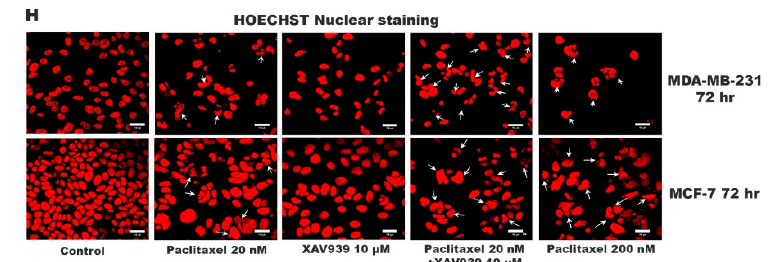
Figure 1. Combination treatment with paclitaxel (20 nM) and XAV939 (10 µM) induced comparable cytotoxicity in triple-negative breast cancer TNBC and estrogen receptor (ER)+ breast cancer cell lines, relative to paclitaxel with a high dose (200 nM). ( A ) The chemical structure of XAV939 and paclitaxel. ( B , C ) Cell viability of MDA-MB-231, MDA-MB-468, BT549, MCF-7, and T-47D cells after various treatments for 24 h, 48 h, and 72 h. ( D ) Cell cycle analysis of MDA-MB-231 treated with paclitaxel and/or XAV939 for 48 h. ( E ) MDA-MB-231 cells were treated with paclitaxel and/or XAV939 for 48 h and stained with annexin V-FITC and propidium iodide and then analyzed by flow cytometry. ( F ) The cell percentage of each cell cycle phase and the percentage of apoptotic cells in each treatment were analyzed statistically and presented in the form of bar graphs in three independent experiments. ( G ) Immunofluorescence images of apoptotic cells by annexin V-FITC and propidium iodide in MDA-MB-231 cells after various treatments for 48 h. ( H ) Nuclear fragmentation assay via Hoechst staining for MDA-MB-231 and MCF-7 cells after 72 h of various treatments. White arrows indicate the chromatin condensation and nuclear fragmentation. Results are expressed as mean ± SD, n = 3. *: p < 0.05; **: p < 0.001 in comparison to each single treatment with either paclitaxel or